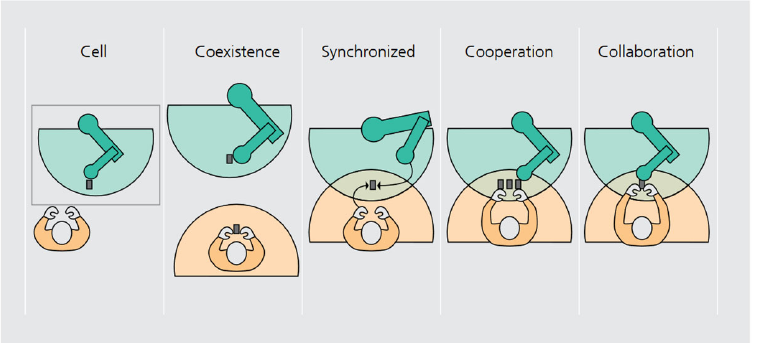
Figure 1. Collaboration levels in human–robot interaction from [18]. The cobot can be integrated with the human in five different modalities depending on the workspace and the tasks shared among the human and robot.